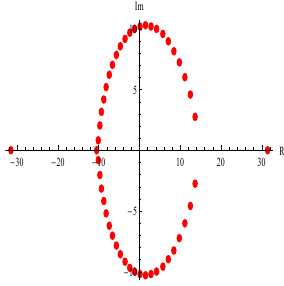
Figure 2. Approximate roots for C B 50,0.9 ( x ,5 ) .